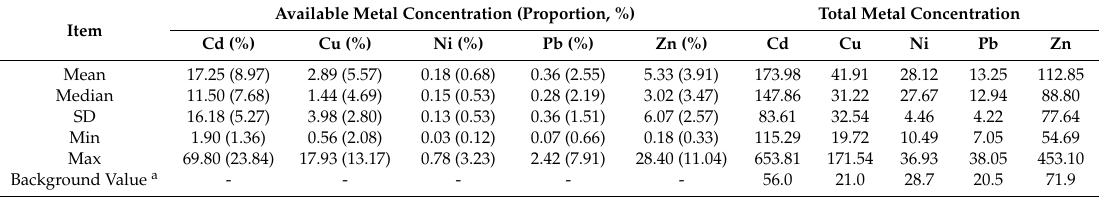
Table 1. The descriptive statistics for heavy metal concentrations (Cd: µ g / kg; others: mg /